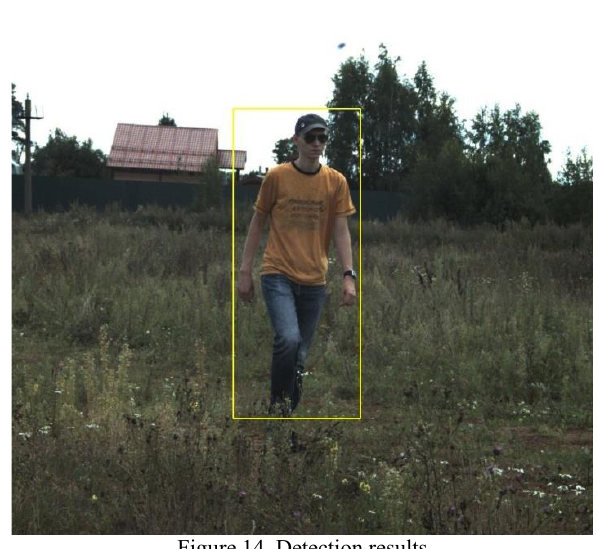
Figure 14. Detection results